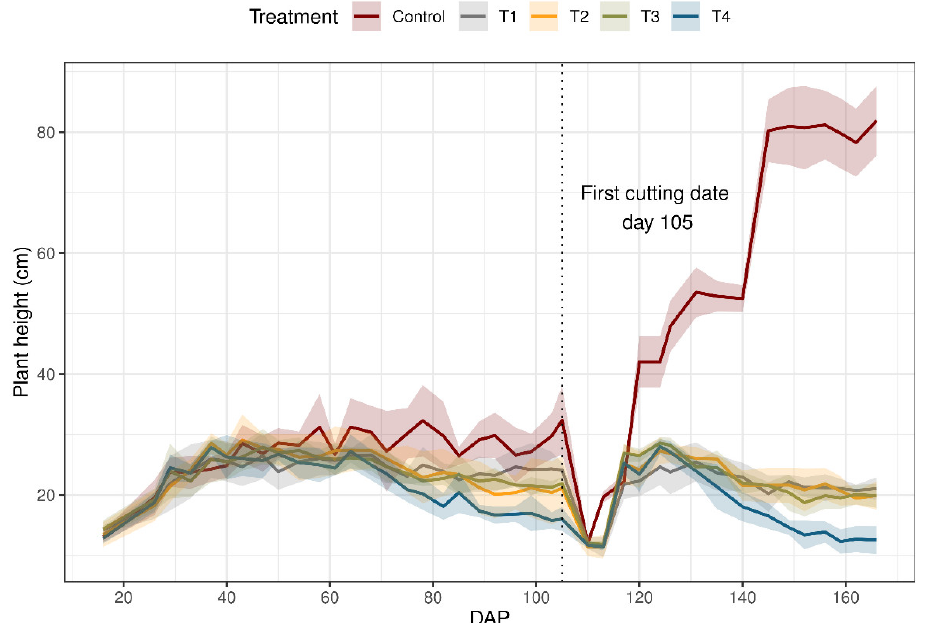
Figure 3. Plant height (ph) of ryegrass (Lolium perenne ) during the growing season under different irrigation treatments. Control: non-stressed treatment, T1: moderate–low water stress treatment, T2: moderate–high water stress treatment, T3: medium intensity severe water stress treatment, T4: high intensity severe water stress treatment. The first cutting was made on day 105. The solid line connects the ph means, and the shaded area shows the standard deviation from the mean values.